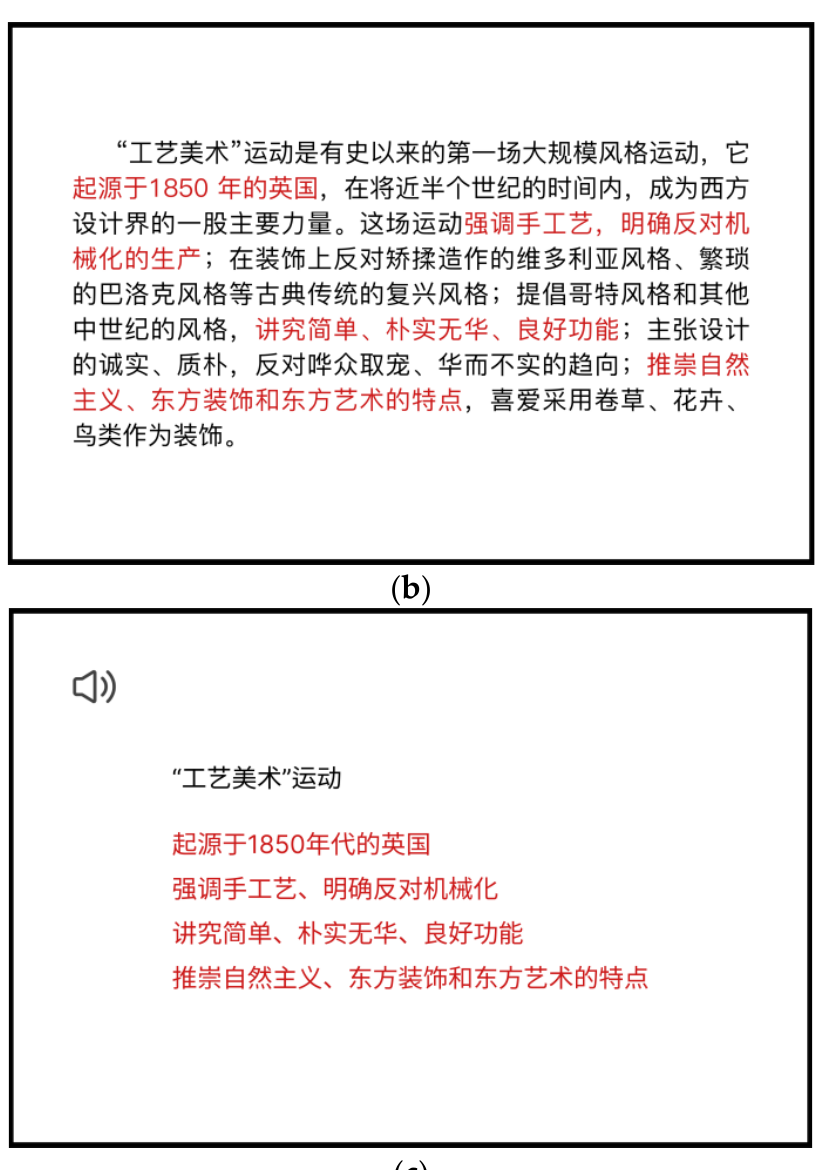
Figure 4. Full text + audio ( a ), full text + key markers ( b ), and some textual information (key markers) + audio ( c ). (Full text: only text information is displayed; audio: information related to content; key markers: marking of key information in the article).